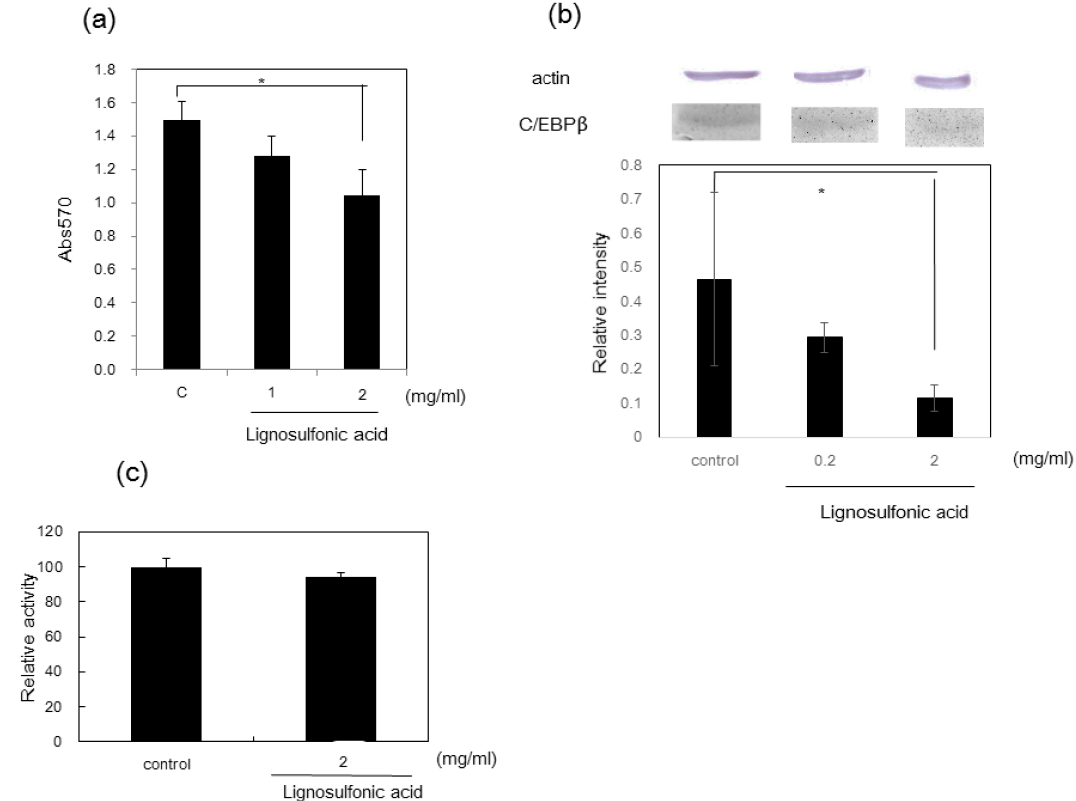
Figure 2. Effect of lignosulfonic acid on preadipocyte proliferation. ( a ) Lignosulfonic acid was added to 3T3-L1 preadipocyte cells at concentrations of 1.0 mg/mL and 2.0 mg/mL compared to control in the absence of lignosulfonic acid; ( b ) effect of lignosulfonic acid on the expression of C/EBP- β ; ( c ) LDH content released into culture medium. Statistical significance was evaluated by Student’s t -test (* p < 0.05). (Reprinted with permission from [16]).